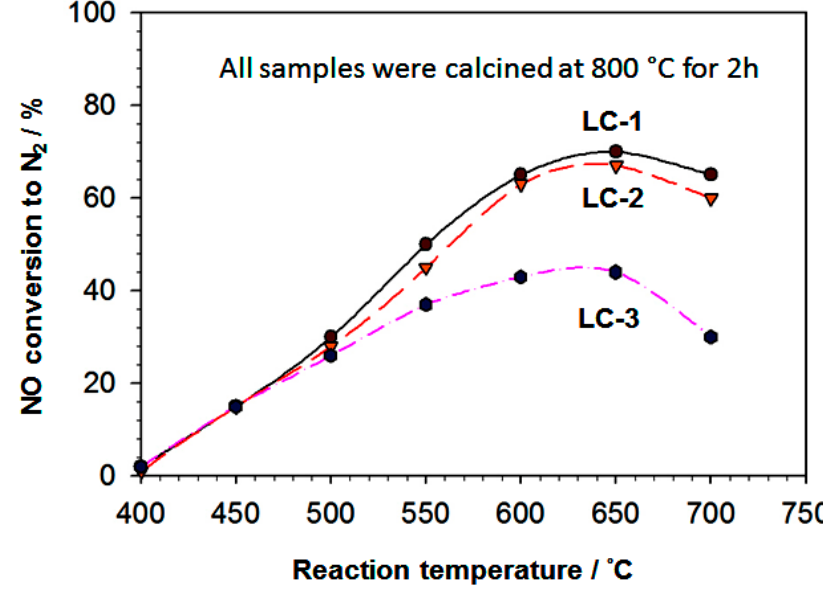
Figure 10. The catalytic activities of LC-1 (referred to as a ′ ), LC-2 (referred to as b ′ ), and LC-3 (referred to as c ′ ) calcined powdered samples with NO reduction as a function of temperature of the reaction. The reactions were performed with a feed containing 1000 ppm NO, 2000 ppm CH 4 , and diluted 5% O 2 in He, and 0.18 g of the catalyst and a GHSV (gas hour space speed) of 20,000 h 1